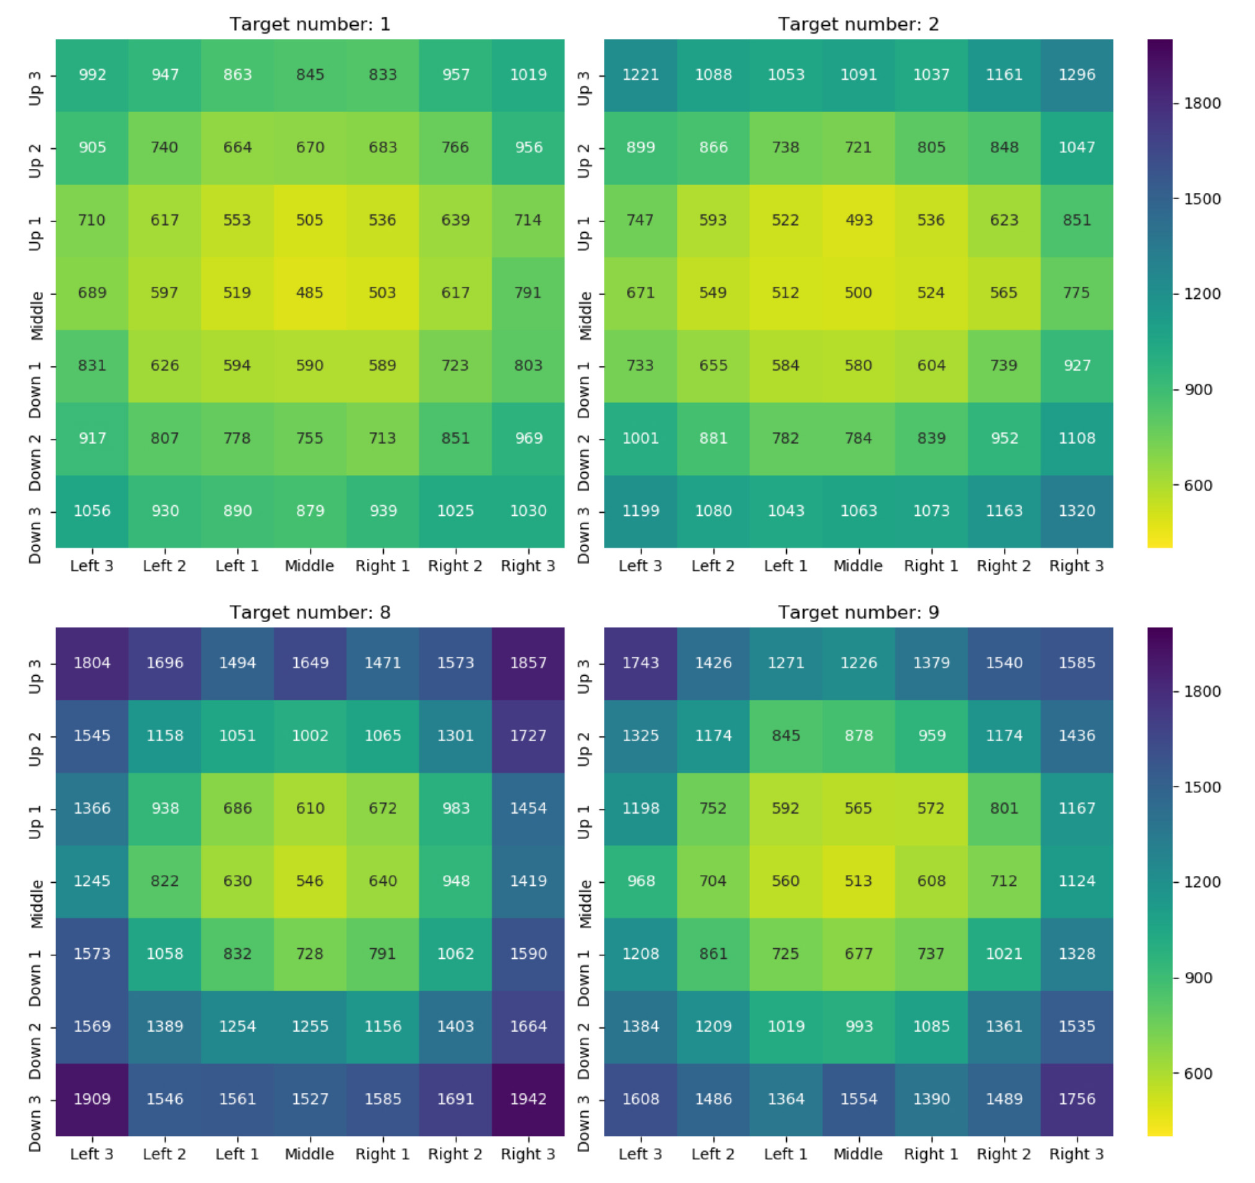
FIGURE 2 | Mean IES (in ms) per target number (see headings) and spatial position within the 7 × 7 grid. Lower values/yellow color represent better performance and higher values/blue color represent worse performance (see color